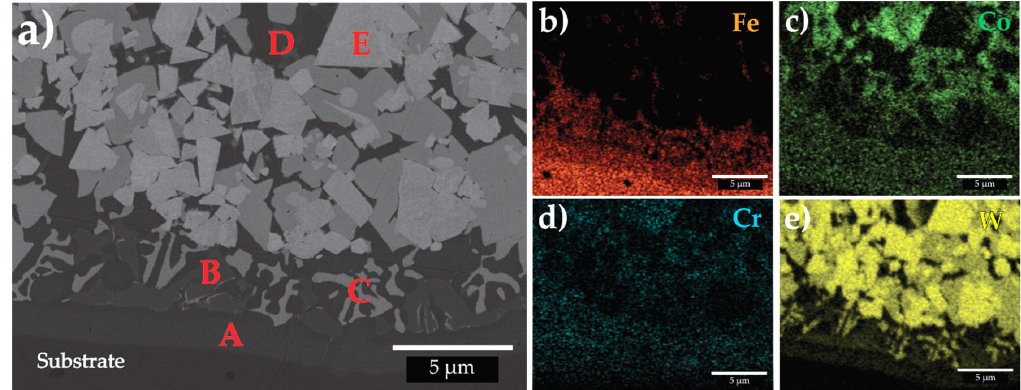
Figure 4. ( a ) Representative microstructure of the interface region; EDS mapping concentration for ( b ) Fe, ( c ) Co, ( d ) Cr and ( e ) W, for sample E a39